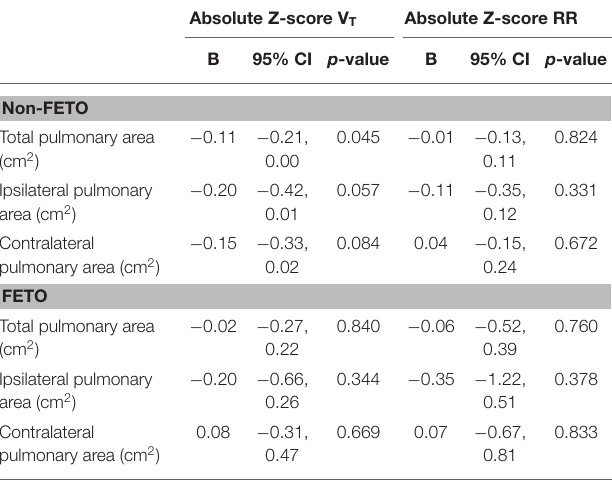
TABLE 4 | Linear regression analysis between radiographic measurements and absolute Z-Score Tidal Volume (V T ) or absolute Z-Score Respiratory Rate (RR) in FETO and non-FETO